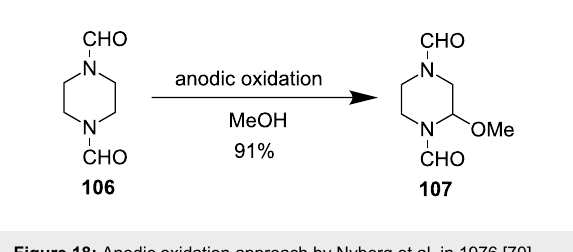
Figure 18: Anodic oxidation approach by Nyberg et al. in 1976